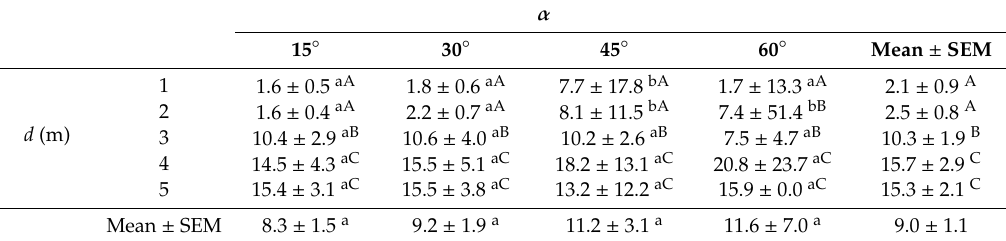
Table 3. Mean absolute percent error (MAPE) of stem circumference at breast height for all combinations of shooting distances and angular shifts.